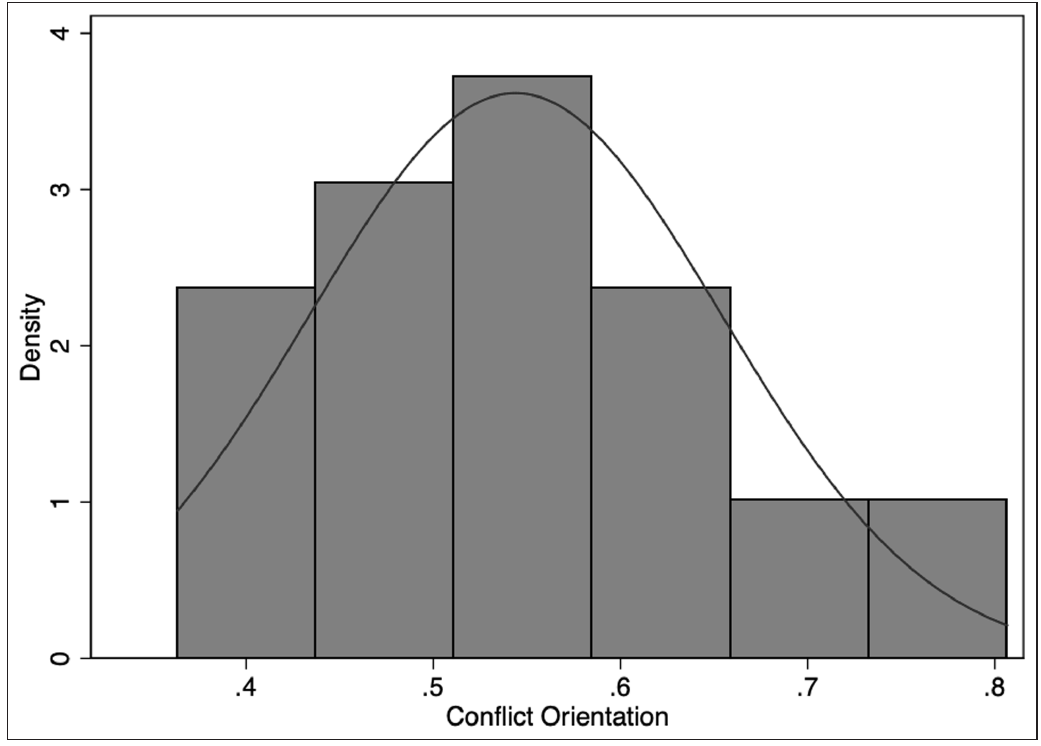
Figure 1: Distribution of Participants’ Conflict Orientation. Note: Conflict orientation was measured on a zero to one scale where zero indicated extreme conflict avoidance and one indicated the most conflict approaching tendencies. The distribution of participants’ orientations is overlaid with a normal